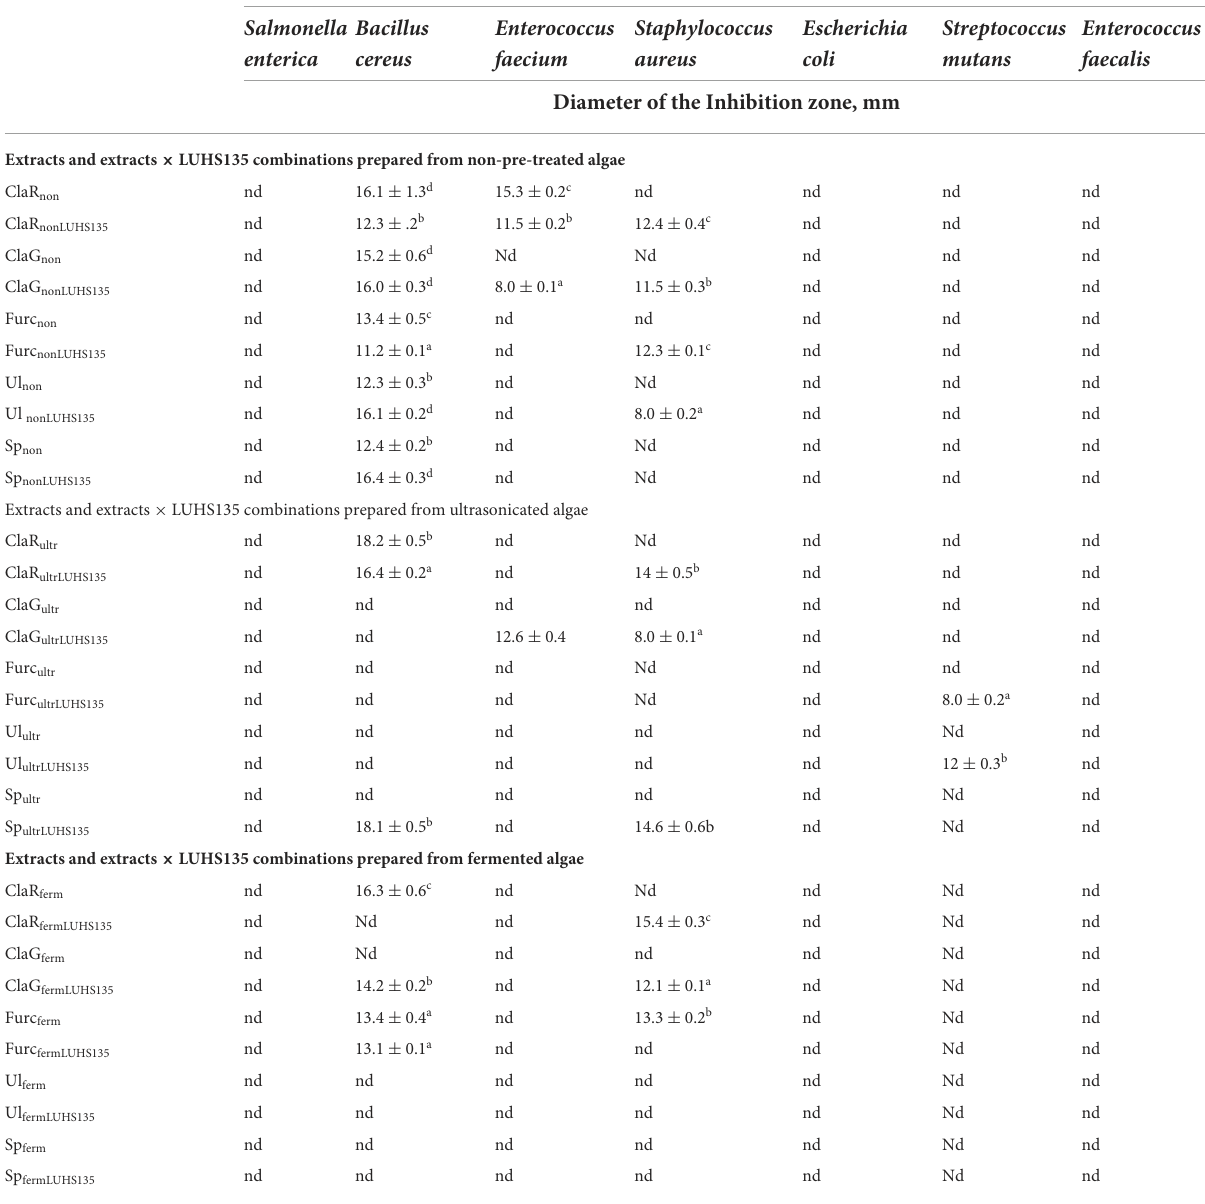
TABLE 4 Antimicrobial activity of the algae extracts and algae extracts × LUHS135 combinations evaluated using the agar well–diffusion method. Extracts and extract